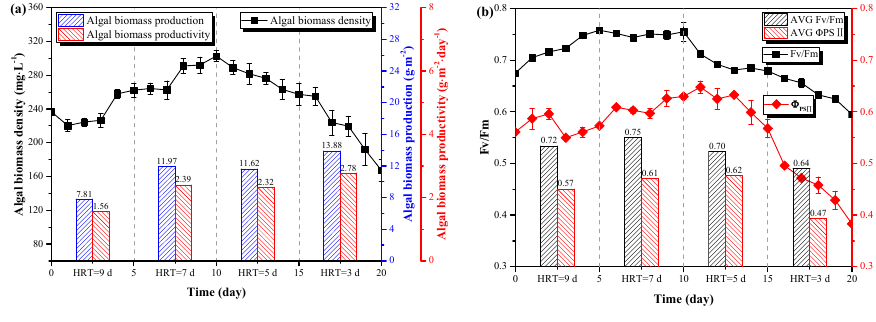
Culture Period Total Day a Night